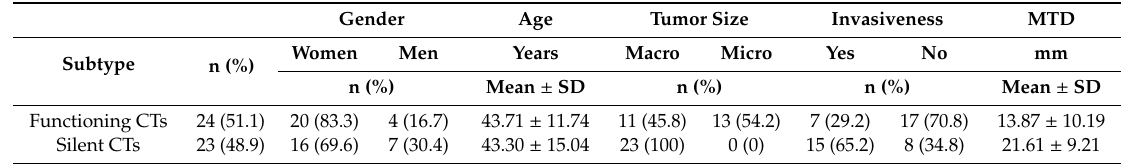
Table 1. Demographic and clinical characteristics of the studied